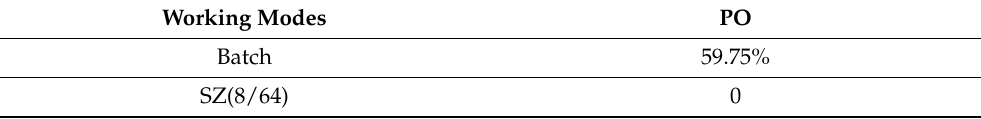
Table 4. The percentage of the mitigation ambiguity ineffective area to the range ambiguity echo